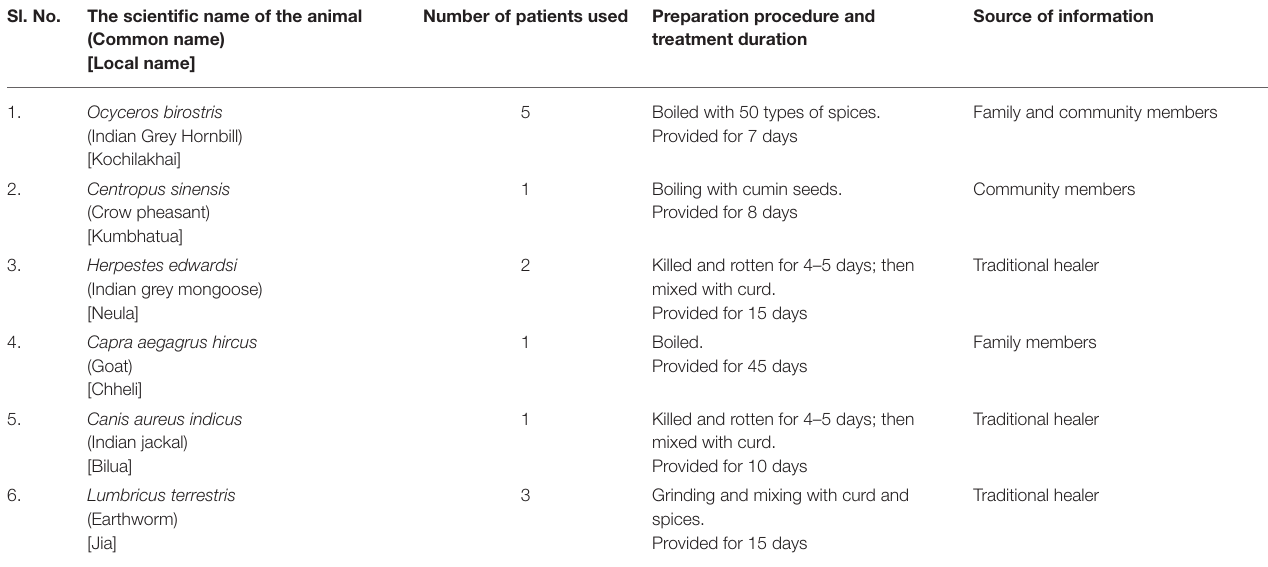
TABLE 2 | Details of animal and animal products used for the treatment of rheumatoid arthritis. Sl.